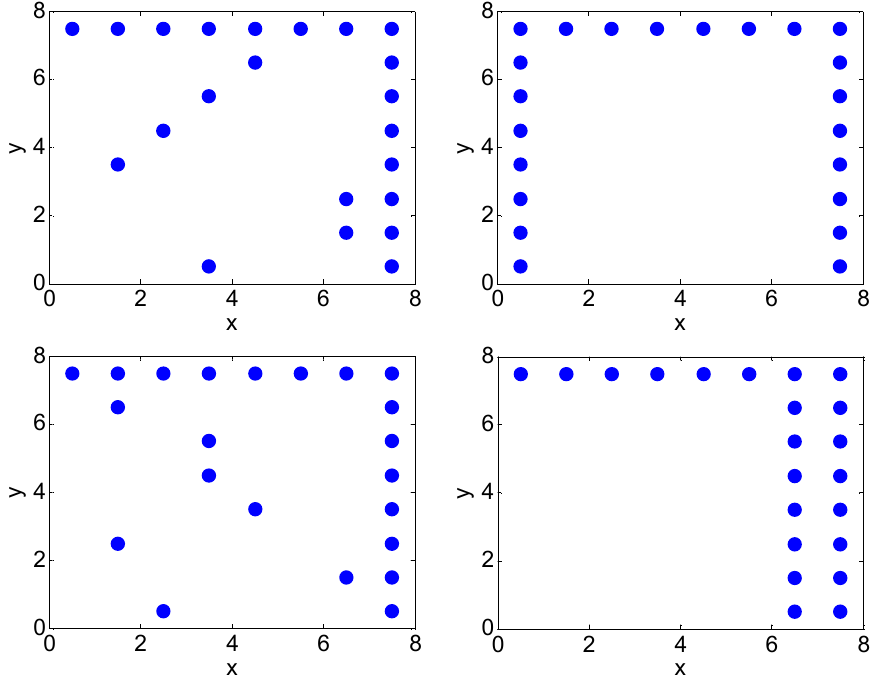
Figure 8. Regular 2-D DPAs.